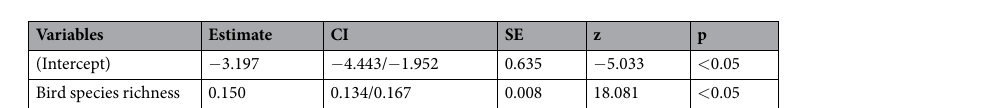
Figure 1. Comparison of average bird species richness between sample sites where cuckoos were present (red boxes) or absent (grey boxes) in twelve European and Asian countries. The box plots show medians, quartiles, 5- and 95-percentiles and extreme values. The map was generated with GIS soſtware (ArcGIS 10.1) 57 with geographical background using data available under the Open Database Licence (“© OpenStreetMap and contributors”; cartography licensed as CC BY-SA) http://www.openstreetmap.org/copyright.